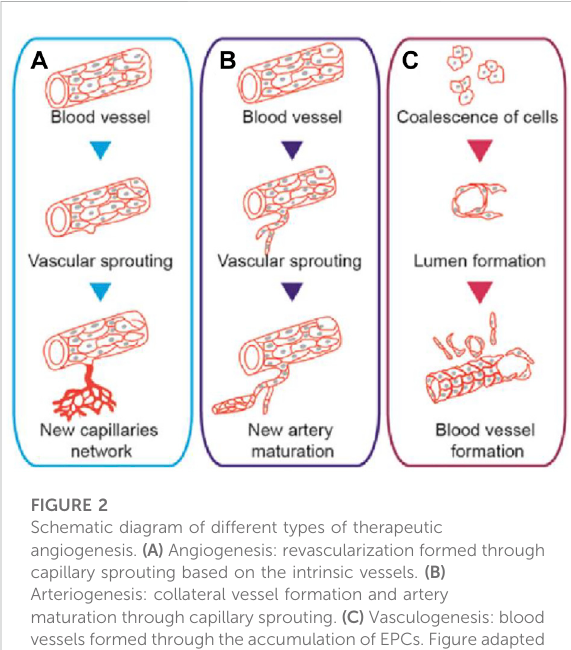
FIGURE 2 Schematic diagram of different types of therapeutic angiogenesis. (A) Angiogenesis: revascularization formed through capillary sprouting based on the intrinsic vessels. (B) Arteriogenesis: collateral vessel formation and artery maturation through capillary sprouting. (C) Vasculogenesis: blood vessels formed through the accumulation of EPCs. Figure adapted with permission from ref. (Xing et al.,